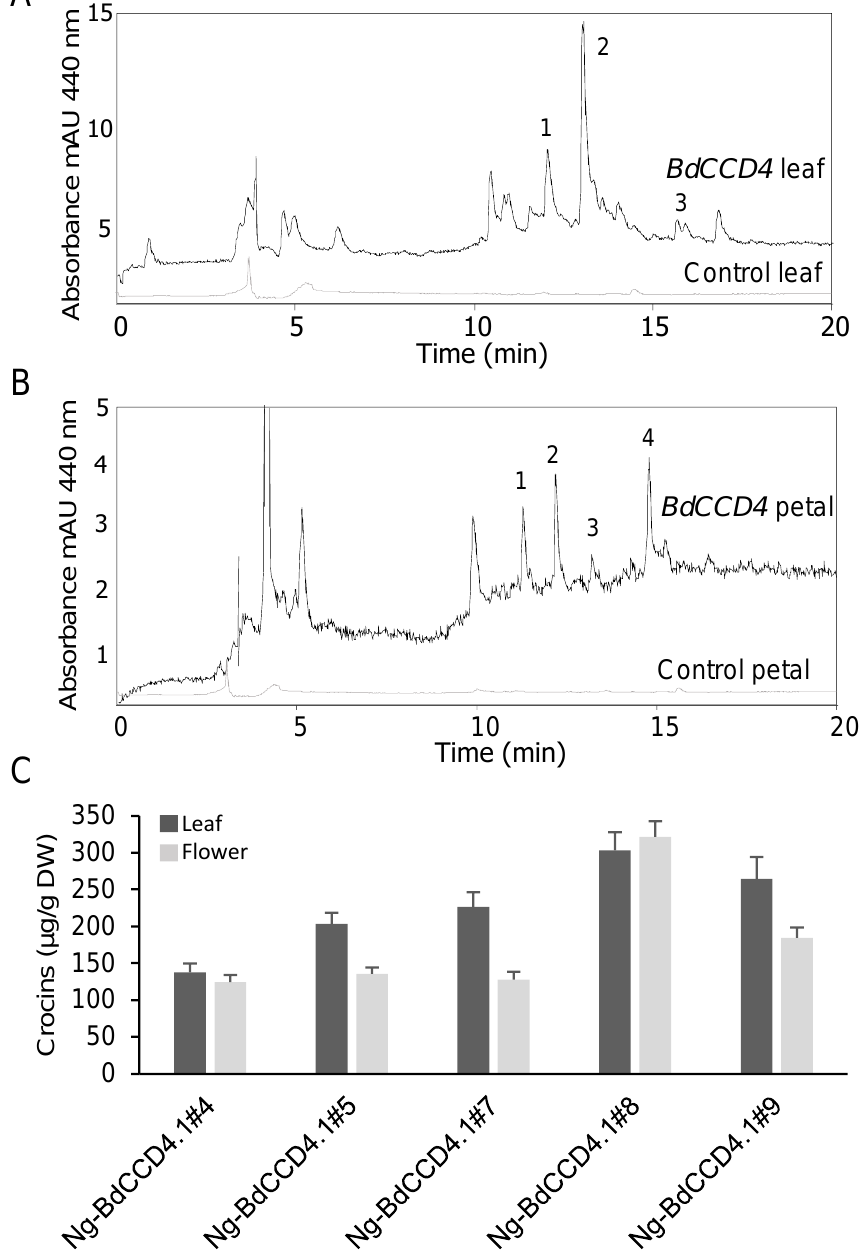
Figure 2. Accumulation of crocins in Wt and transgenic T1 lines of Nicotiana glauca constitutively expressing BdCCD4.1 . ( A ) HPLC-DAD analysis of polar extracts of Wt and N. glauca leaves at 440 nm. ( B ) HPLC-DAD analysis of polar extracts from transgenic and Wt N. glauca petals at 440 nm. Peaks for the abundant crocins in the transgenic lines are denoted by numbers in leaves (1 = trans-crocin 3; 2 = trans-crocin 2; 3 = cis-crocin 2) and petals (1 = trans-crocin 4; 2 = trans-crocin 3; 3 = trans-crocin 2; 4 = cis-crocin 2); these crocins were completely absent from Wt plants. mAU, milli-absorbance units. ( C ) Apocarotenoid accumulation in the leaves and petals of transgenic lines. Analyses were conducted in triplicate. Error bars represent the SD. DW, dry weight.